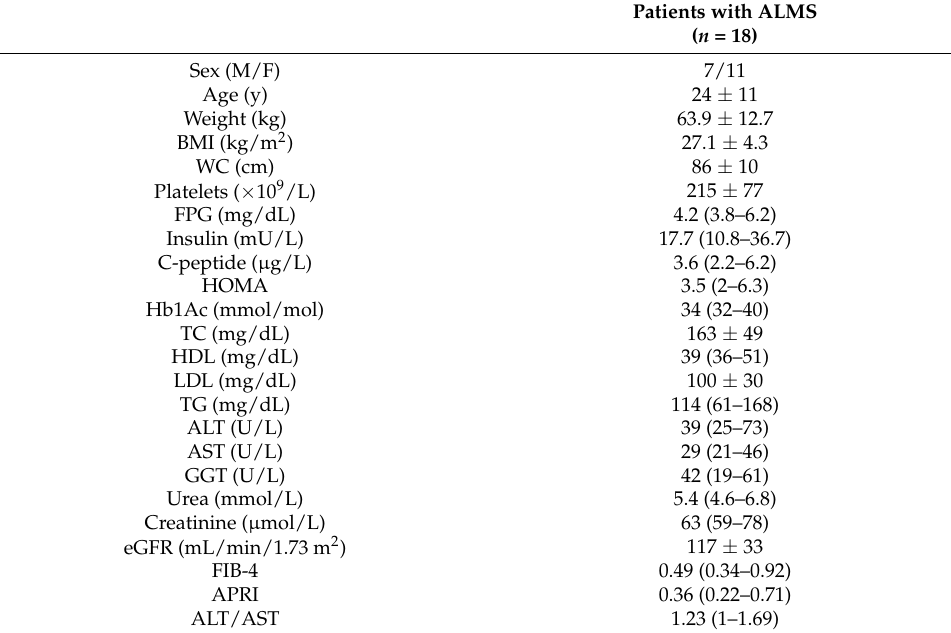
Table 1. Anthropometric characteristics and biochemical parameters in 18 patients with Alström syndrome (ALMS). Data are presented as the mean values ± SDs when the normality test (Shapiro– Wilk) and the equal variance test (Brown–Forsythe) were passed or, if not, as the median value (25th–75th percentile).